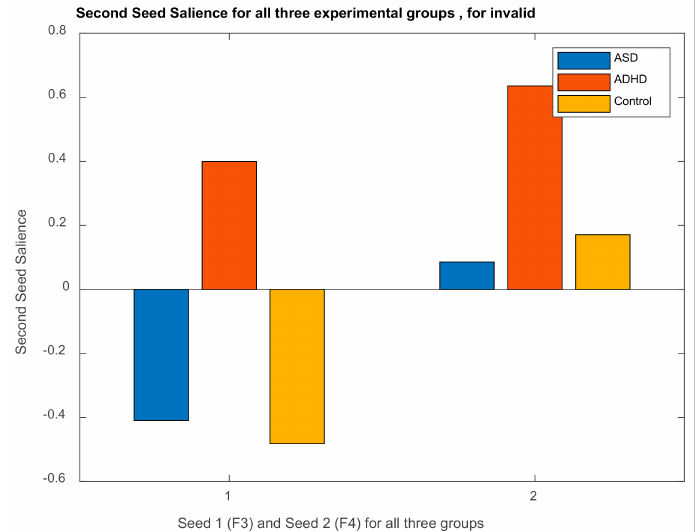
Figure 29. Plot of second seed salience, vs. seeds 1 and 2 (MSE values at F3 and F4, respectively), for all groups, in the invalid